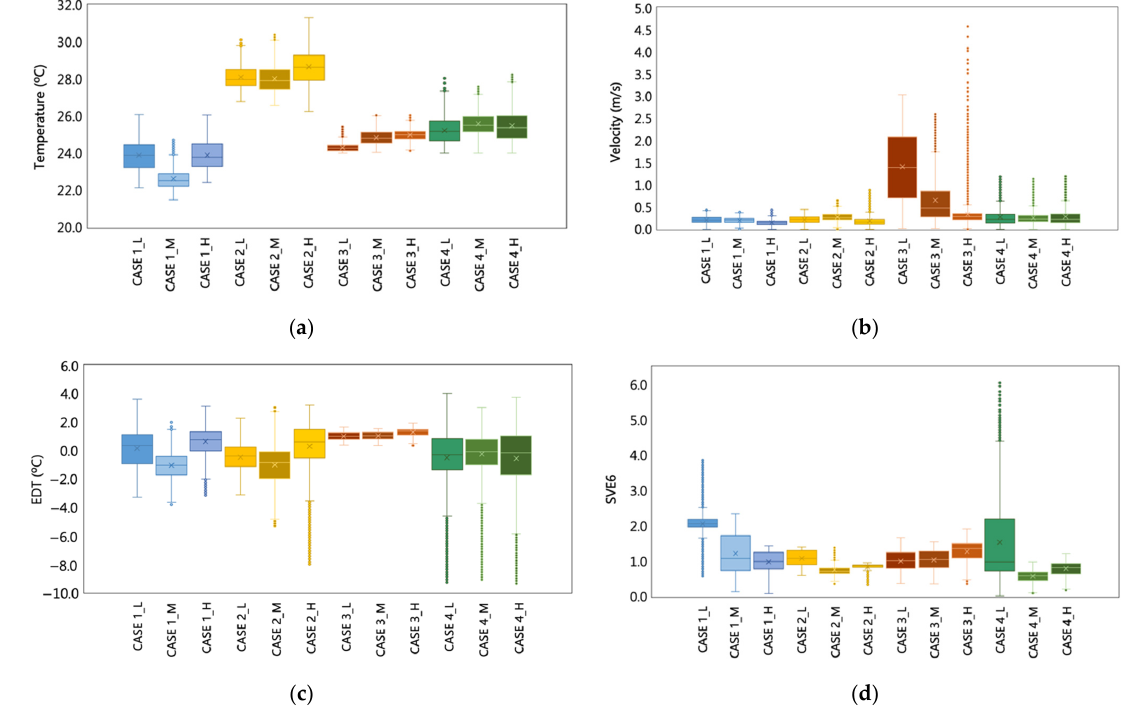
Figure 21. Data box diagram of seats in different areas of each scheme: ( a ) Temperature; ( b ) Air velocity; ( c ) EDT; ( d ) SVE6.